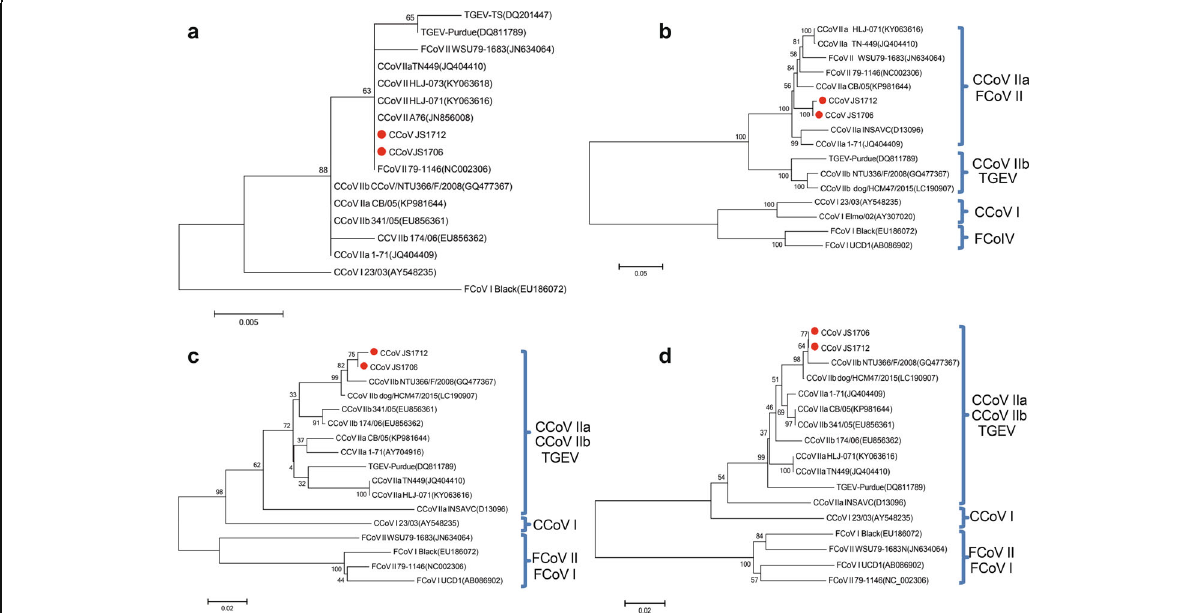
Fig. 5 Phylogenetic analysis based on amino acid sequences of RdRp (a), S (b), M (c) and N (d) proteins. The red circles indicate strains isolated in this study. Scale bars represent the numbers of amino acid substitutions per site. The name and accession number of each strain are